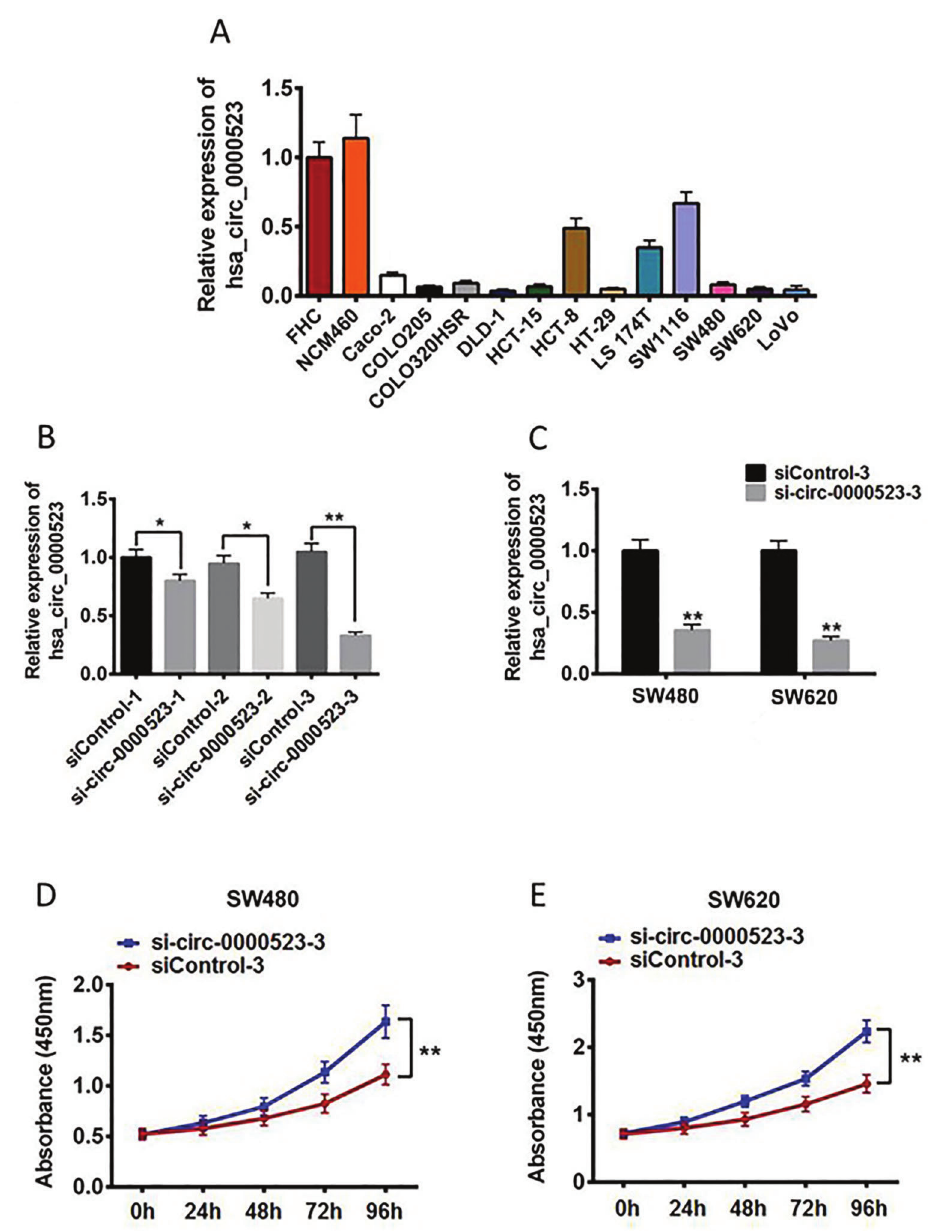
Figure 1. A , Expression pro fi le of hsa_circ_0000523 in 12 different human colorectal cancer cell lines and 2 human normal intestinal cell lines (FHC and NCM460). B , hsa_circ_0000523 expression levels in FHC cells after transfection with 3 siRNAs targeting hsa_circ_ 0000523 and corresponding control siRNAs. CircRNA expression levels were assessed by qPCR and normalized to GAPDH. C , hsa_circ_0000523 expression levels in SW480 and SW620 cells transfected with si-circ_0000523-3 and siControl-3. Cells were harvested after 24 h. CircRNA expression levels were assessed by qPCR and normalized to GAPDH. Cell viability of SW480 ( D ) and SW620 ( E ) were assessed using the CCK8 assay after siRNA transfection (100 m M). The experiments were performed in triplicate independently. Data are reported as means ± SE. *P o 0.05; **P o 0.01 (ANOVA or t 24 h (Figure 3A and B) and both early and late apoptosis with that after 24 h. The results demonstrated that hsa_ rates (Figure 3A and C) and the total apoptosis rate circ_0000523 inhibited colorectal cancer cell proliferation, (Figure 3B and D) increased slightly after 48 h compared by potentially inducing cell apoptosis.